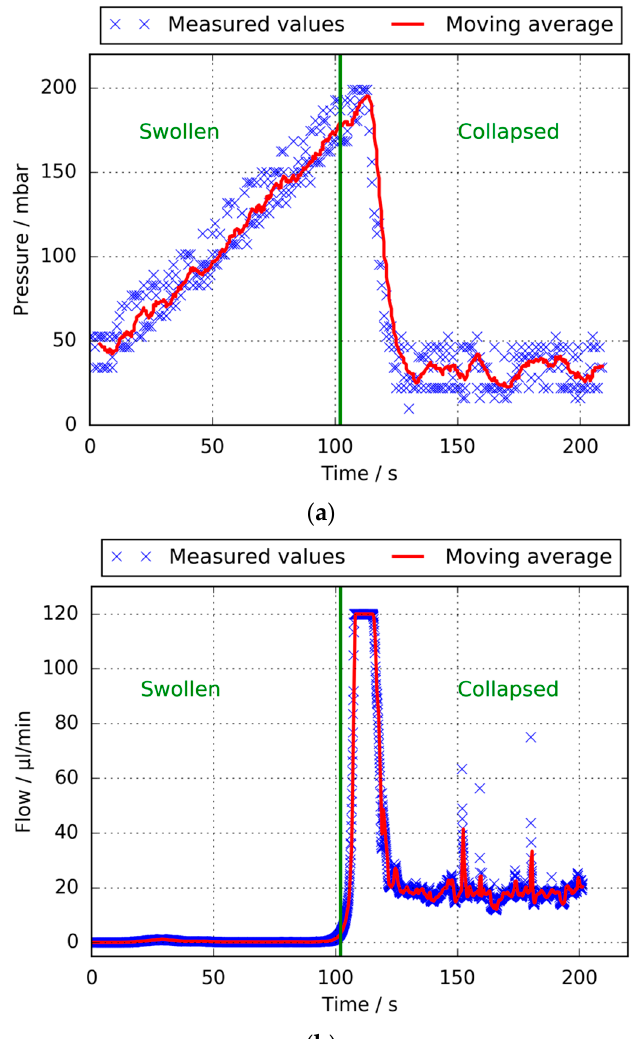
Figure 2. Proof-of-concept for the application as microvalve: Pressure ( a ) and flow ( b ) within the system for the swollen and collapsed state of the hydrogel, the green line indicates the power-on event of the stimulus. For the swollen hydrogel, the channel is blocked so that no significant flow occurs and the pressure rises. When the hydrogel collapses, the channel is opened leading to a decrease in pressure and the liquid flows through the